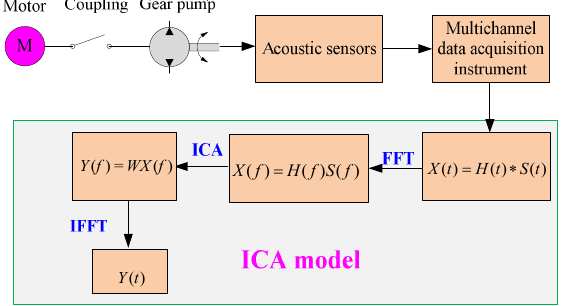
Figure 7. Separation process of the noise source of the gear pump.